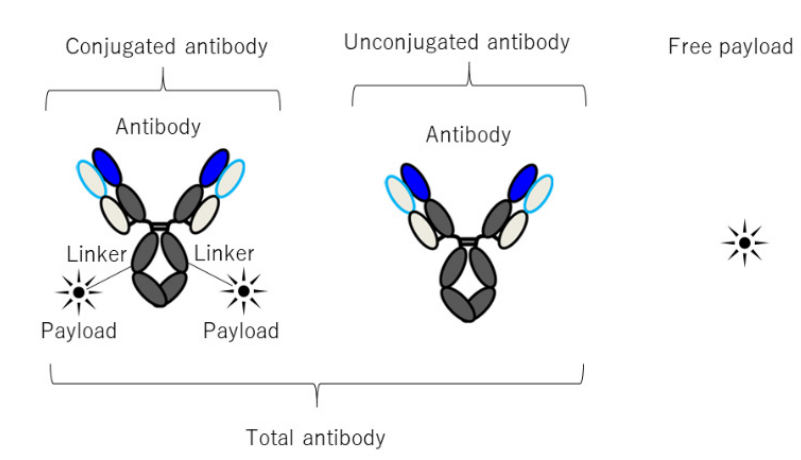
Figure 4. Structure and nomenclature of